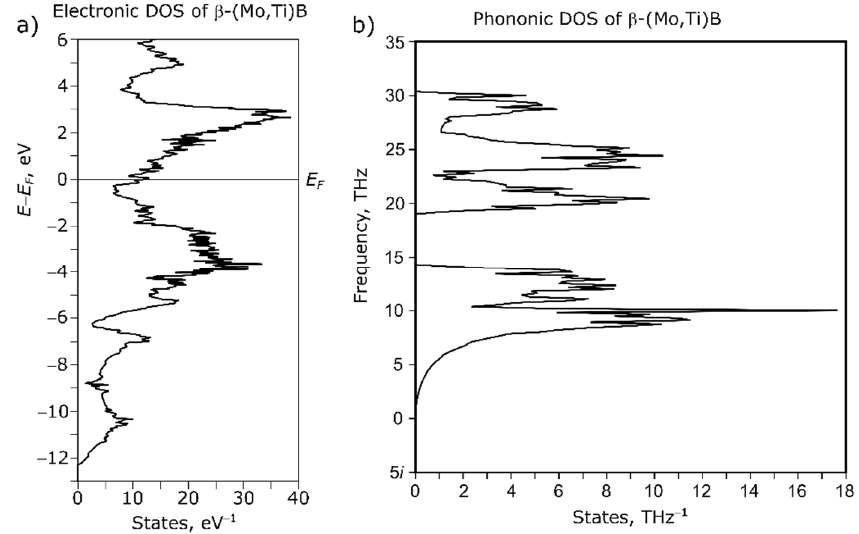
Figure 9. Electronic ( a ) and phononic ( b ) density-of-states of β -(Mo,Ti)B.